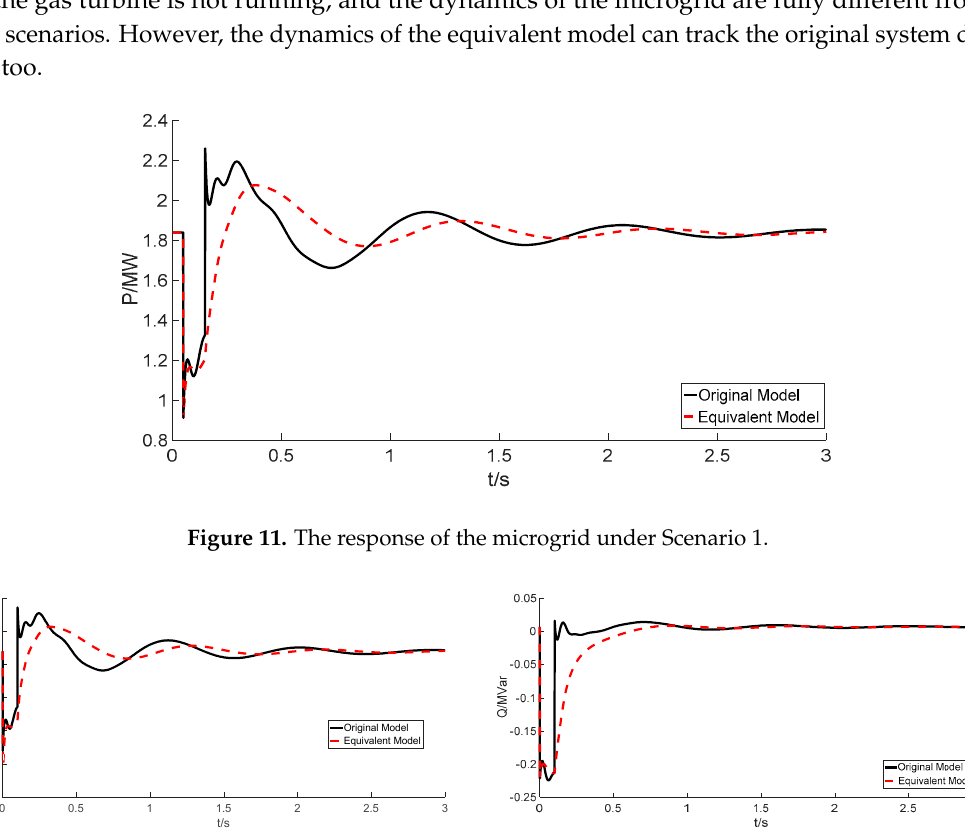
Figure 13. The active response of the microgrid in Scenario 2.